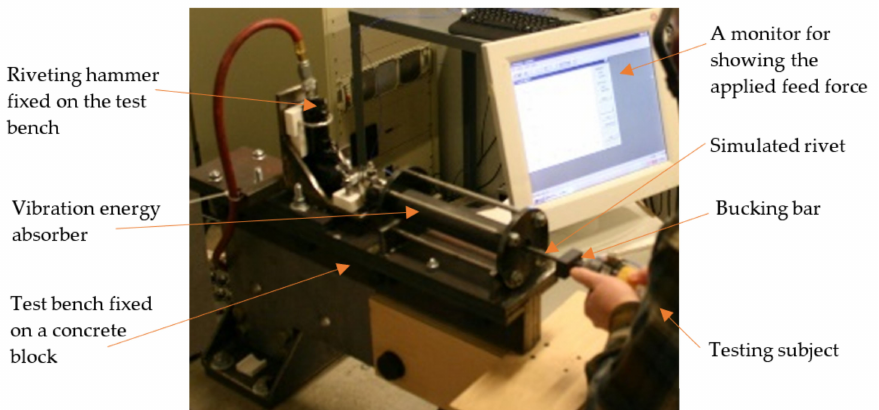
Figure 13. A proposed bucking bar test rig [150], which is composed of the following components: (i) A remote-controlled pneumatic riveting hammer programmed to deliver consistent vibration stim- uli; (ii) An energy absorber for dampening the vibration input to the simulated rivet; (iii) A simulated rivet; (iv) A force plate for measuring the ground reaction force (feed force); and (v) A computer monitor for displaying the applied feed force as a strip chart allowing the bucking bar operator to maintain the target force within the specified range. The tested bucking bar is pressed against the simulated rivet by a test subject. Tri-axial acceleration data are simultaneously collected at the riveting hammer, the bucking bar, and at the right wrist of the bucking bar